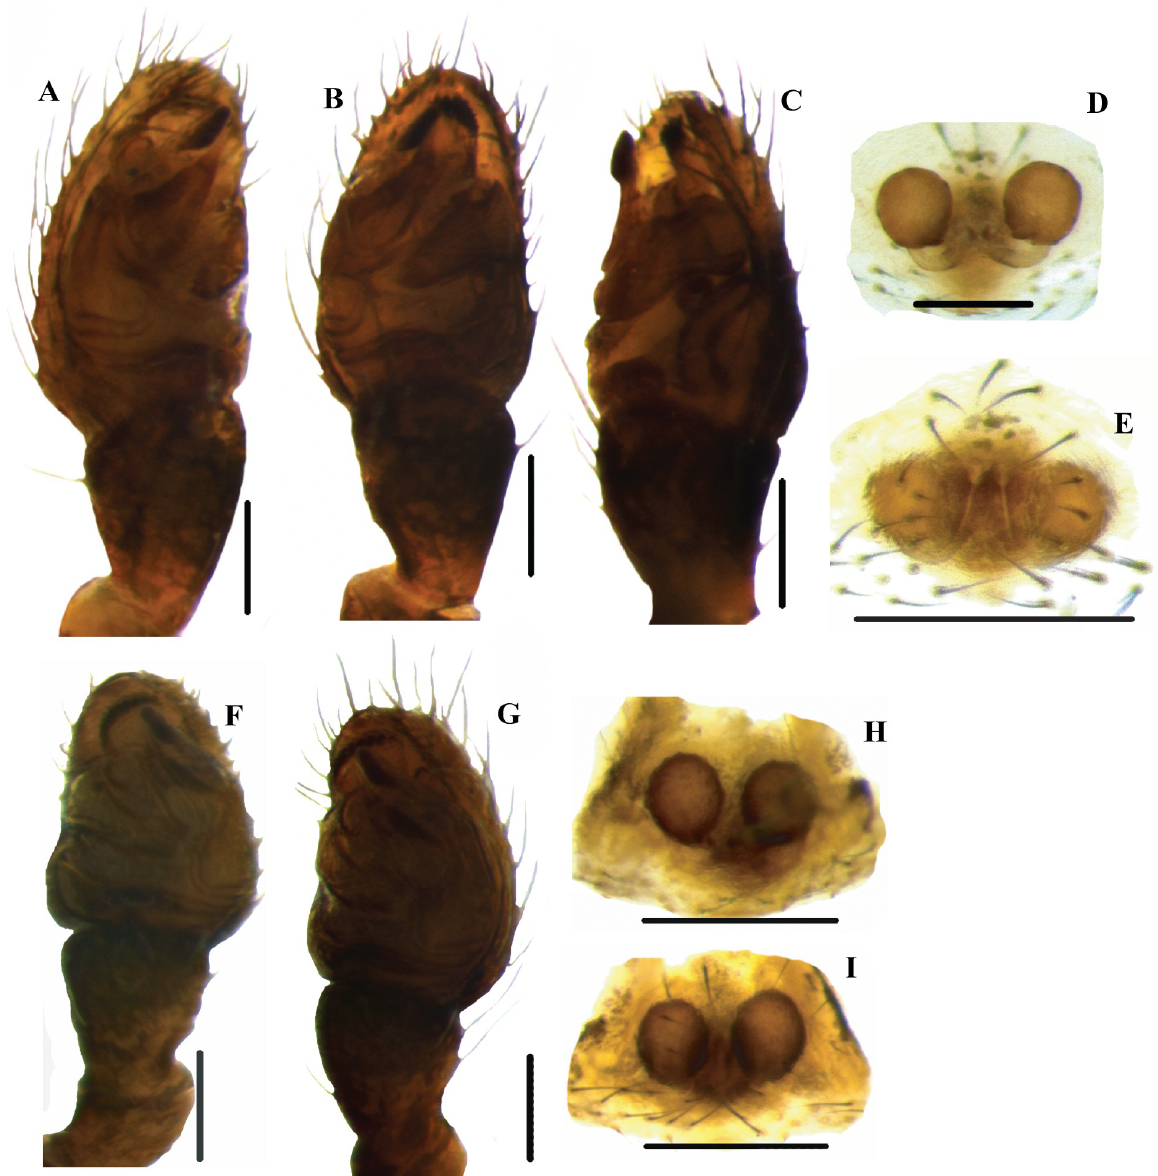
Fig 9. Genital morphology of Neospintharus species in Sri Lanka. A–E, N . kandelensis sp. nov. A–C, male palp (left). A prolateral view; B ventral view; C retrolateral view. D–E, Epigynum. D, dorsal view; E, ventral view. F–I, N . ohiyiaensis sp. nov. F, male palp (left), ventral view; G, same, retrolateral view; H, epigynum dorsal view; I, same, ventral view. Scale bars = 0.1 mm (A–D, F–G), 0.2 mm (E, H, I). than PMEs, square orientation of AMEs and PMEs. Separation of posterior medians slightly more than the separation of anterior medians. Eye measurements: AME 0.1, ALE 0.06, PME 0.1, PLE 0.06, PME-PME 0.1, PLE-PLE 0.36, ALE-PME 0.06, and ALE-PLE 0 (fused laterals). Opisthosoma nearly triangular, light grey with silvery hue or spots, dorsal opisthosoma more concentrated with a band of silver hue, posterior opisthosoma blunt darker grey hue and characteristically both lateral sides with a larger circular marking filled with darkened grey flecks. Spinnerets; light grey, placed in the middle and lower edge of opisthosoma, total length 1.98, opisthosoma length 1.08 and opisthosoma width 0.74. Leg measurements: leg I: 4.48